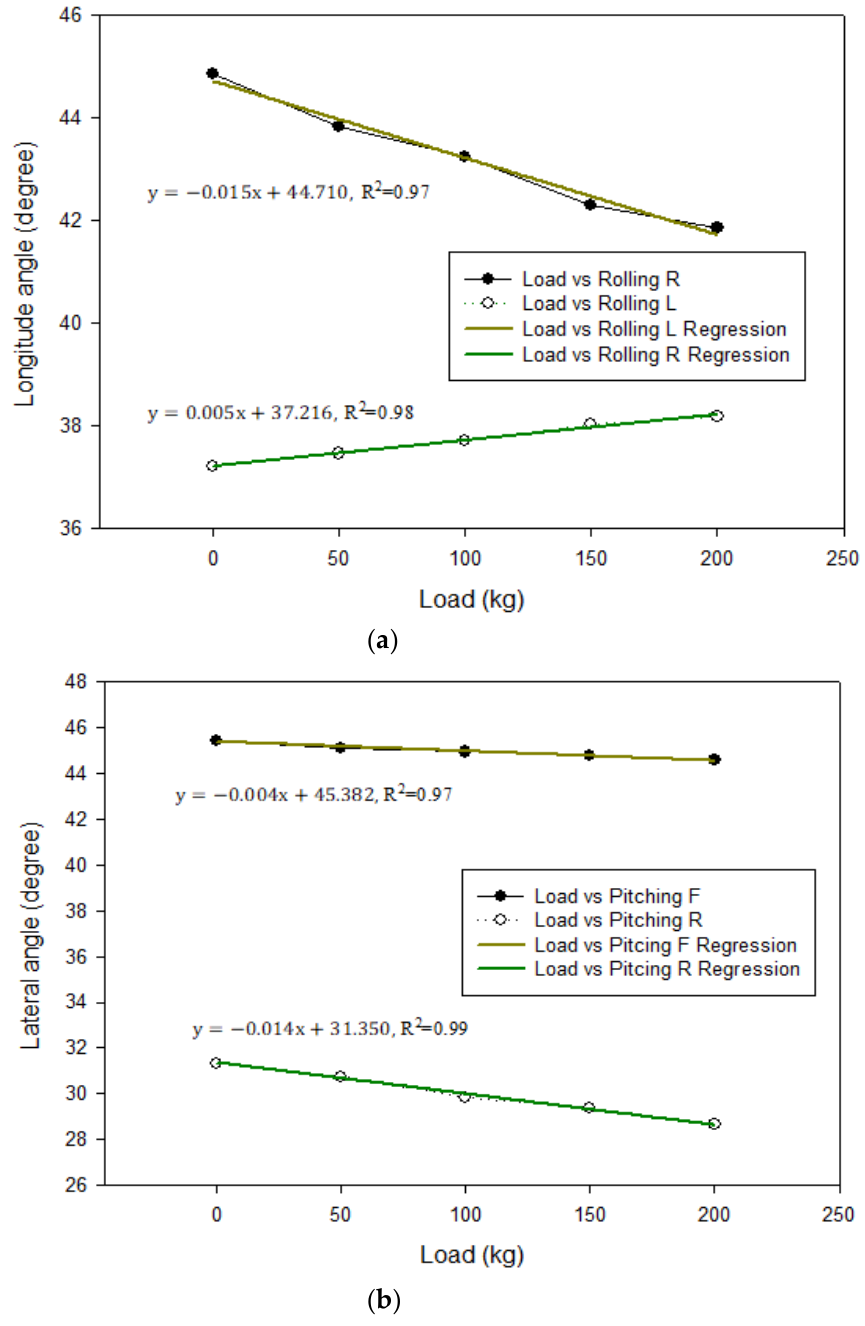
Figure 4. Overturning angle of cargo in each loading condition ( a ) X direction ( b ) Y direction.